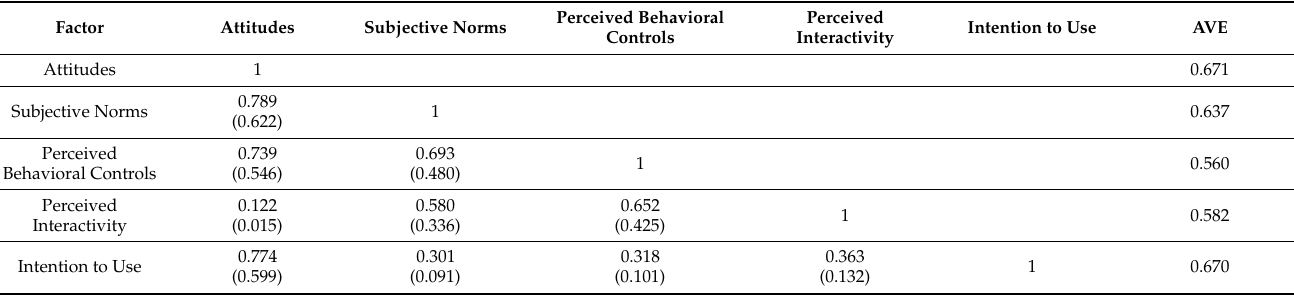
Table 3. Results of correlation